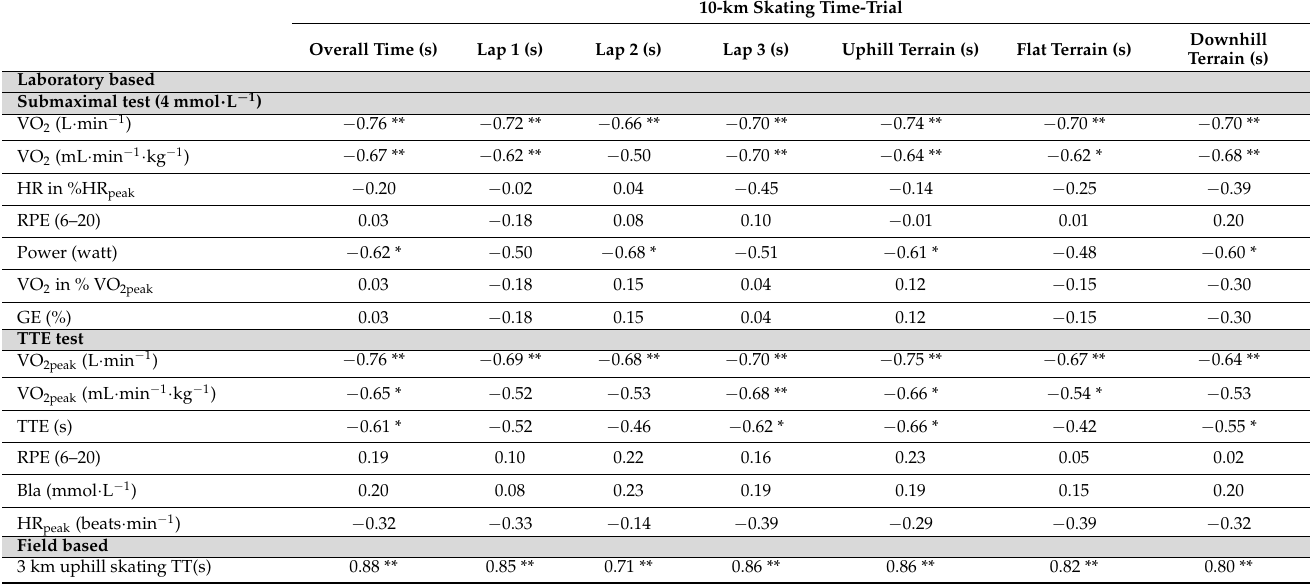
Table 6. Correlations of laboratory and field-based tests with overall performance and perfor- mance in different terrains during a 10 km skating time-trial in fourteen national-level male cross-country skiers. Table 5. Laboratory-based data from a submaximal blood lactate profile and time to exhaustion test during roller-ski skating in fourteen national-level male cross-country skiers.